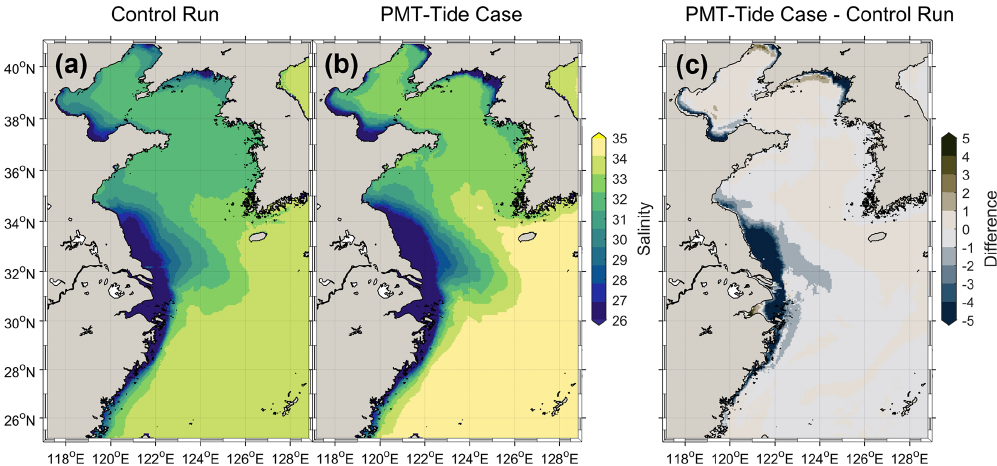
Figure 14. The annually and vertically averaged salinity of the shelf water for the control run (a) , the PMT–tide case (b) , and their differ- ence (c) . Positive (negative) values denote the salinity of the no-tide case higher (lower) than that of the control